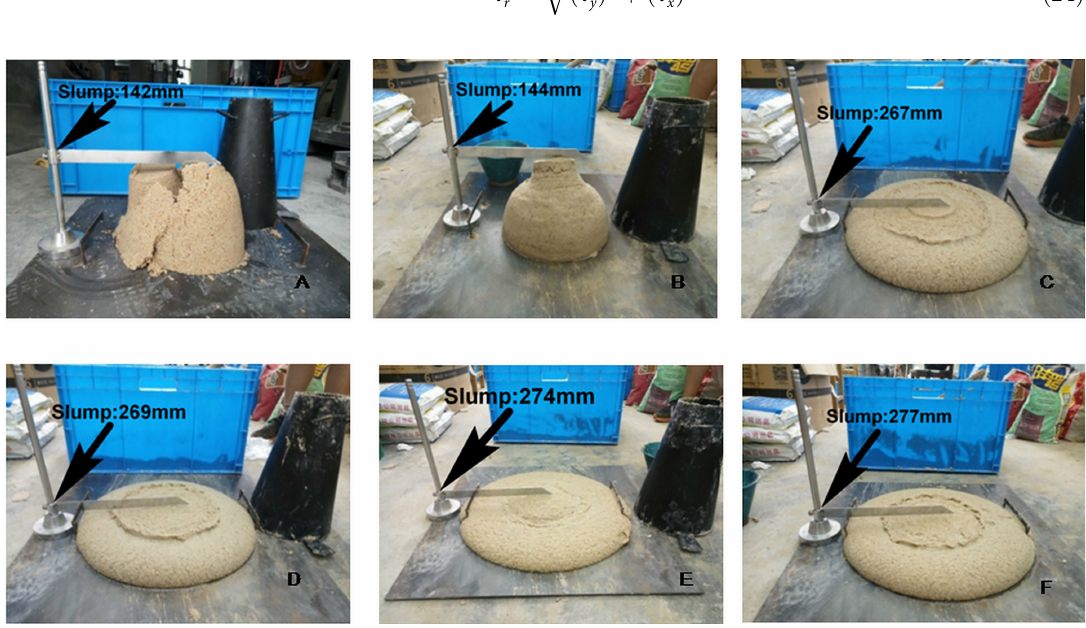
Fig 10. The slump tests of composite additive conditioning soil. (A) Only 15% bentonite slurry. (B) 15% bentonite slurry with 10% foam solution. (C) 15% bentonite slurry with 20% foam solution. (D) 15% bentonite slurry with 30% foam solution. (E) 15% bentonite slurry with 40% foam solution. (F) 15% bentonite slurry with 50% foam